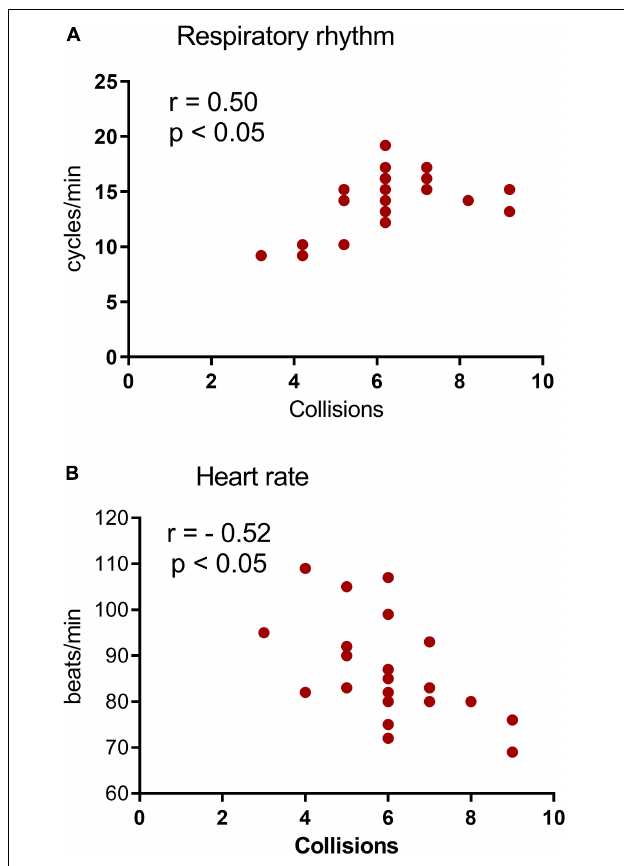
FIGURE 4 | Subject-specific differences in respiratory rate (RR) and heart rate (HR) in the high fear condition (phase 3) of the VRP. (A,B) Scatterplots of RR (A) and HR (B) correlated with collisions in the high predator condition. Each point represents the recorded RR or HR in phase 3 of the VRP from each subject. n = 22. The number of points is less than the actual number of subjects because of several overlaps.